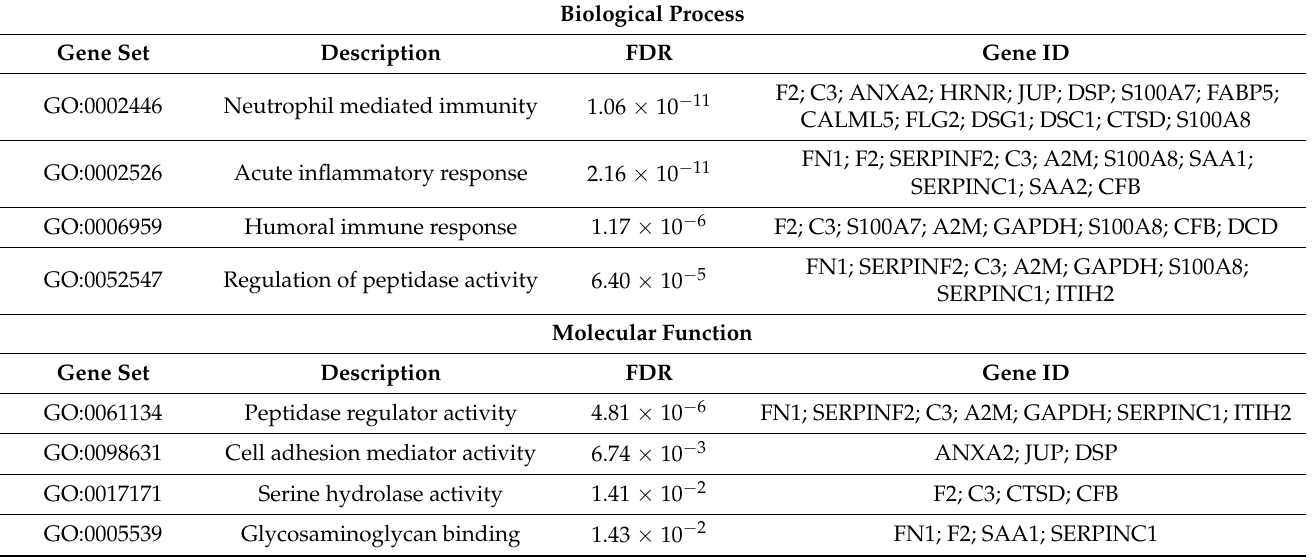
Table 2. Gene Ontology analyses of the differentially expressed proteins after 6-month treatment with